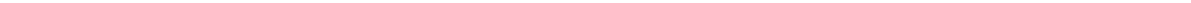
Fig. 4 Assessment of ROS generation in SCV in the presence or absence of FPN. a Protein carbonylation in SCV of Raw264.7 cells treated with PBS, hepcidin, or DFO, as determined using 2,4-dinitrophenylhydrazine. SCV were isolated using magnetized Salmonella (MOI, 100) 2 h p.i. Proteins with 2,4- dinitrophenylhydrazine groups were quanti fi ed using a speci fi c antibody. b Lipid peroxidation was determined in cells treated as in a . c – g ROS biosensor Salmonella ( katGp-gfpOVA 16 ) that fl uoresce green in the presence of hydrogen peroxide were used to assess ROS levels in SCV. c Green fl uorescence of katGp-gfpOVA -expressing Salmonella treated with 10 μ M H 2 O 2 . d Expression of katGp-gfpOVA in the Salmonella infecting Raw264.7 cells pretreated with PBS, hepcidin (1 μ g/ml), or DFO (100 μ M). Images were taken 2 h p.i. using a confocal microscope. f Expression of katGp-gfpOVA in the Salmonella infecting C57BL/6 mice treated with GSK5182 (FPN + ) or PBS (FPN − ). Spleens of mice infected with Salmonella i.v. (1 × 10 5 CFU) were examined by confocal microscopy 2.5 days p.i. d , f Nuclei were stained with DAPI (blue), Salmonella with a speci fi c antibody (red), and katGp-gfpOVA expression is shown in green. Scale bars, 10 μ m. e , g The fractions of biosensor-positive (green) cells were quanti fi ed as a percentage of the total intra-macrophage Salmonella (red) in the experiment shown in d , f . Data are presented as means ± SEM. Signi fi cance is indicated as **** p < 0.0001 by two-tailed Student ’ s t